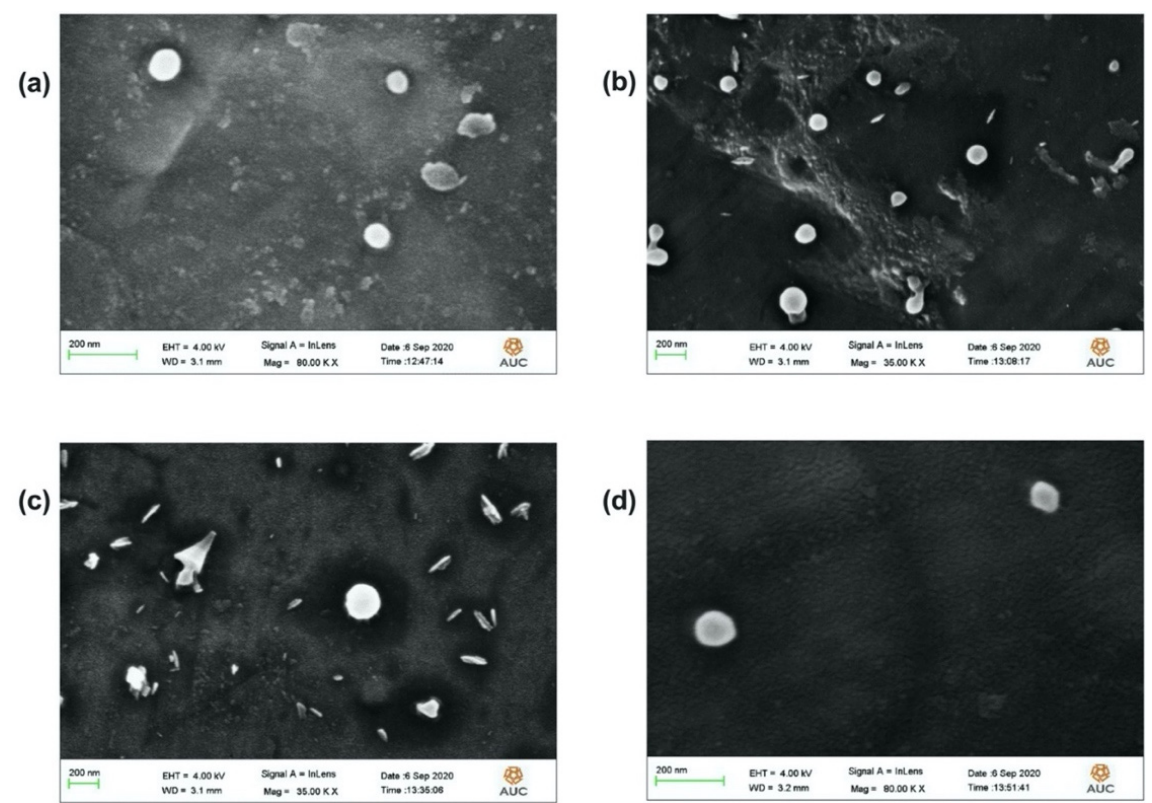
Figure 5. FE-SEM images of PLGA NPs ( a ), PLGA-Cf-F 1 ( b ), PLGA-Cf-F 2 ( c ), and PLGA-Cf-F 3 ( d ).